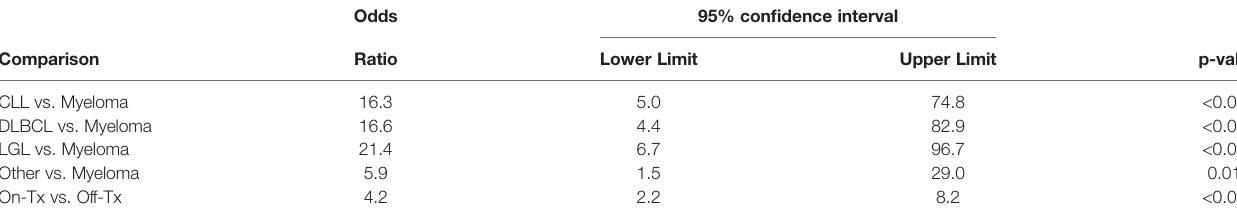
TABLE 4 | Results from the multivariable logistic regression model for NON-response to Covid-19